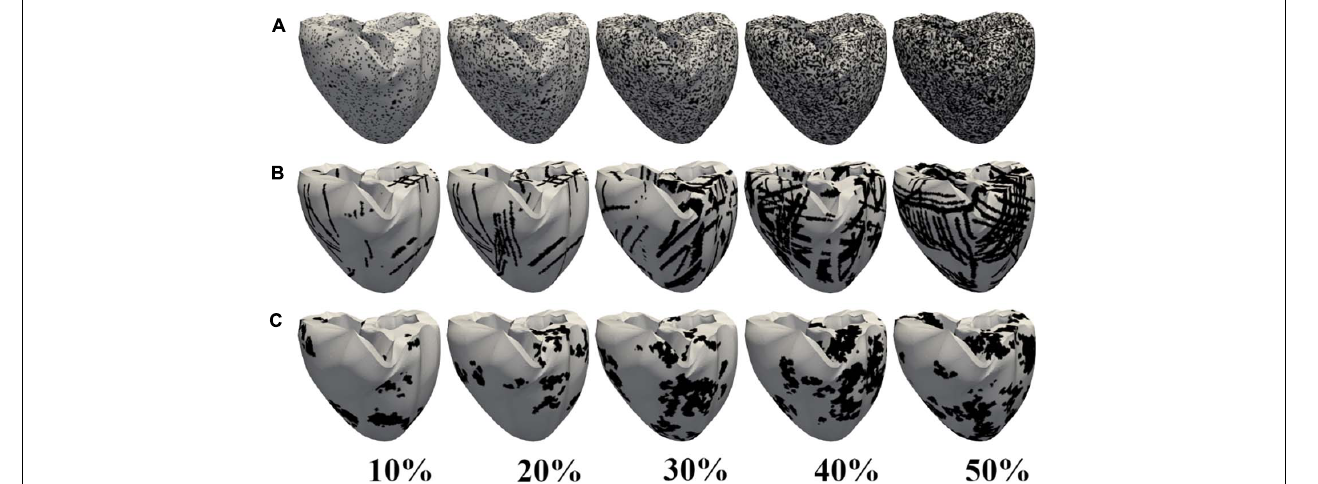
FIGURE 2 | Fibrosis patterns generated. Diffuse (A) , patchy (B) , and compact (C) fibrosis patterns. The black regions indicate areas of fibrosis.